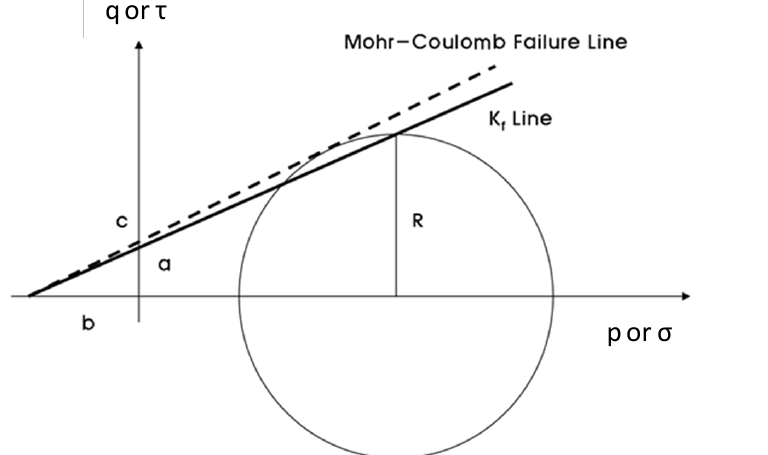
line and Mohr-Coulomb f